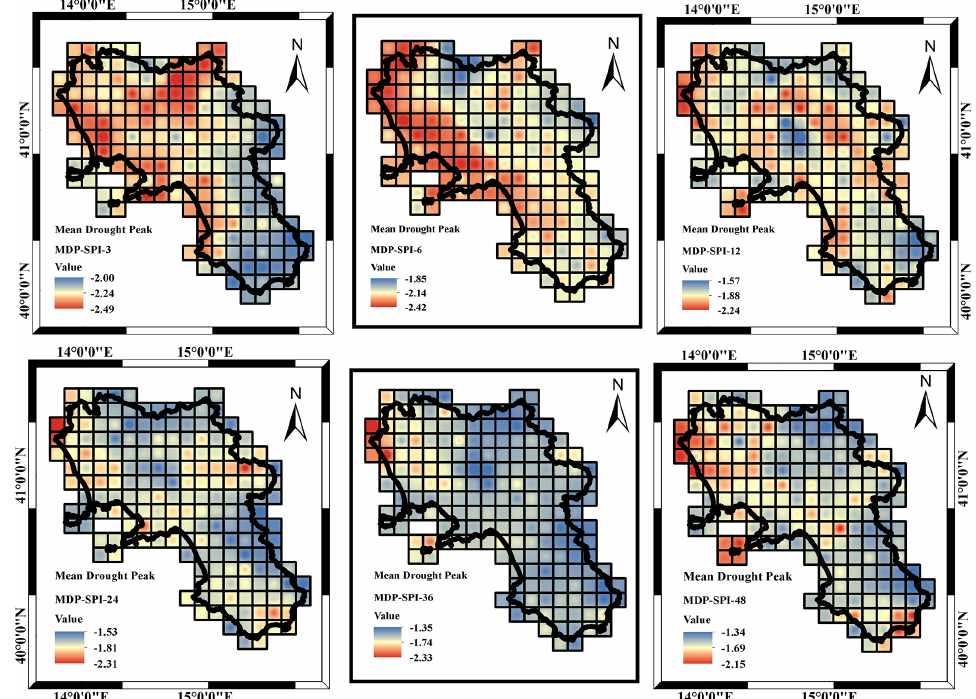
Figure 10. MDP (mean drought peak) for the different accumulation periods considered (SPI ≤ − 1).